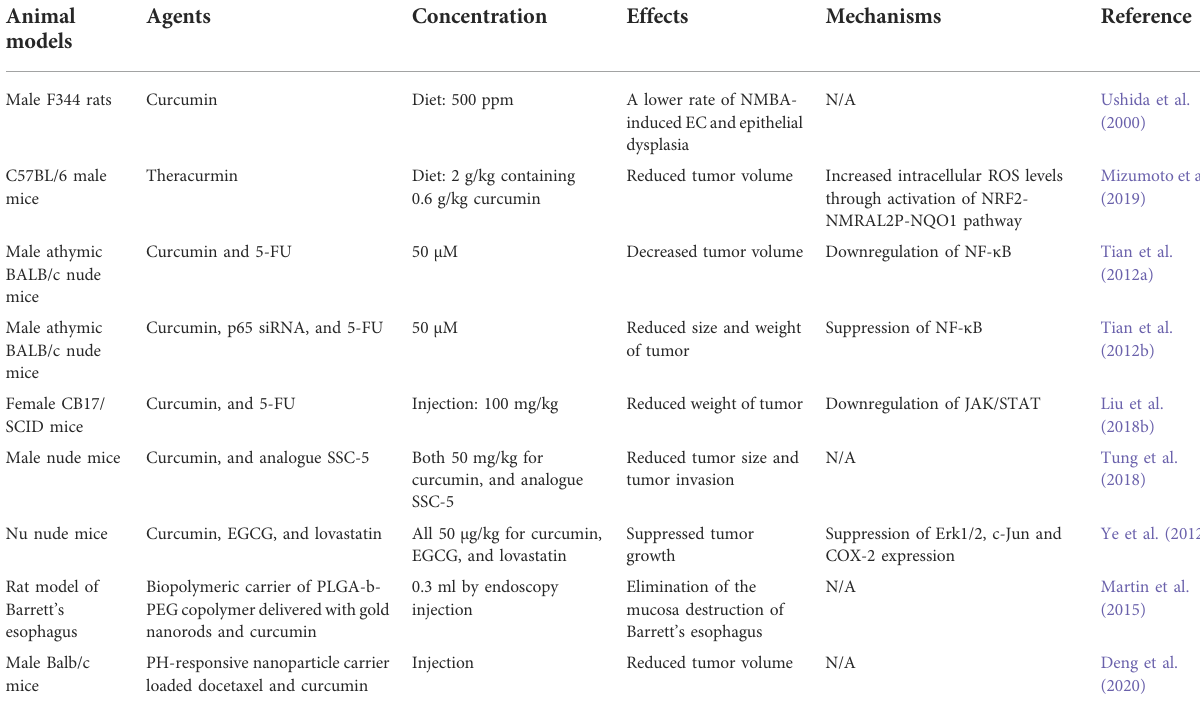
TABLE 2 In vivo studies for curcumin effects on EC. Animal